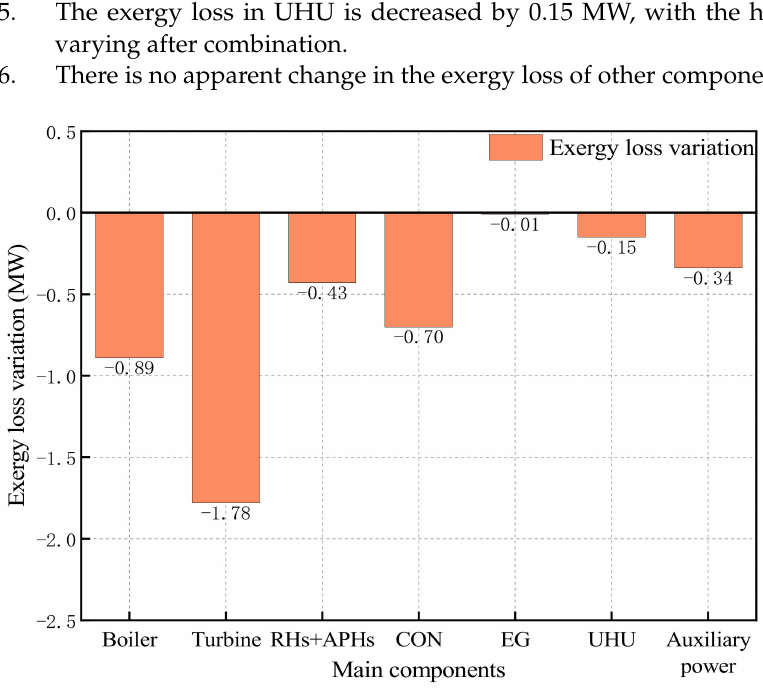
Figure 6. Exergy loss variation of several main components after system